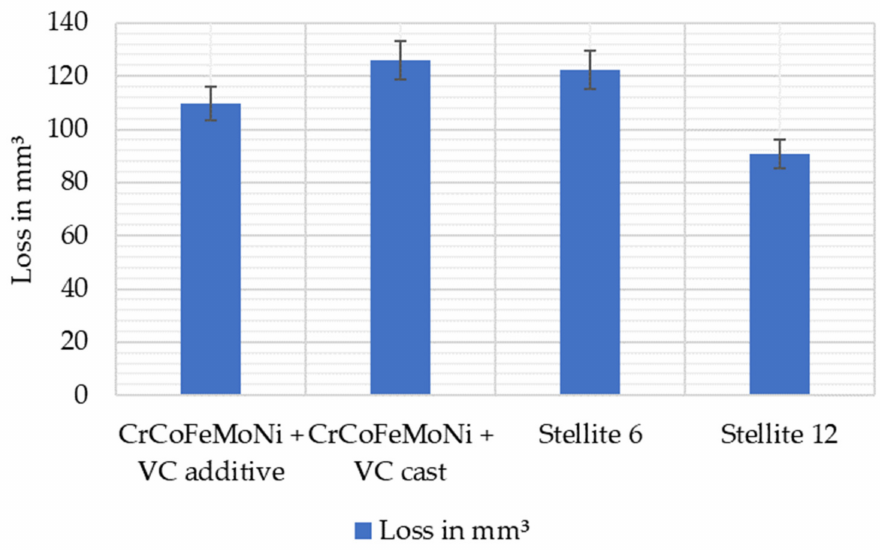
Figure 11. Loss in mm 3 for G75 “Miller”